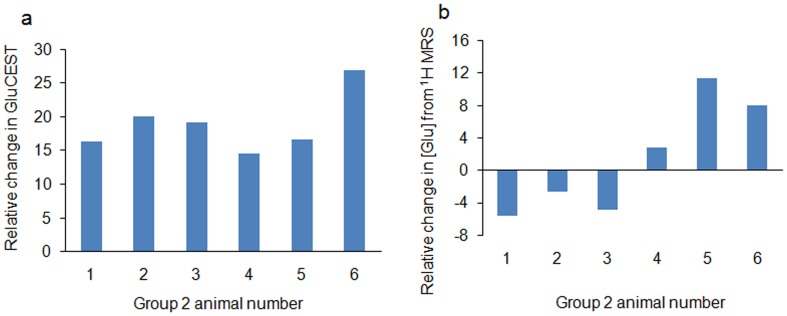
Relative change in GluCEST and Glx concentration from 1HMRS.Bar graphs show relative change in GluCEST contrast (a) and Glx concentration from 1HMRS (b) 24 hours post Modafinil administration for the group 2 rats (n = 6). While the change in GluCEST was positive in all rats, the change in Glx concentration was inconsistent.